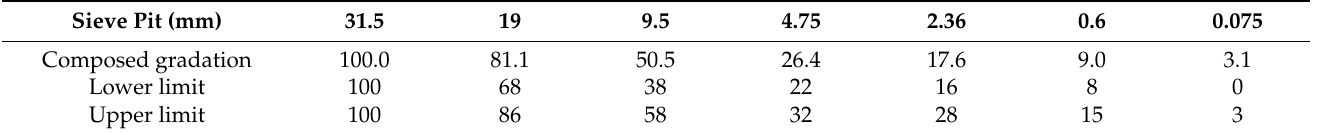
Table 6. Aggregate gradation passing rate of CSG.